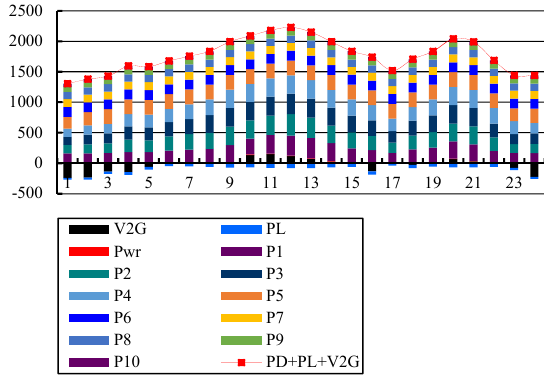
Figure 12. Power balance constraint verification.